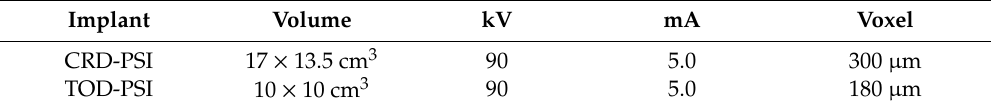
Table 1. Cone-beam computed tomography